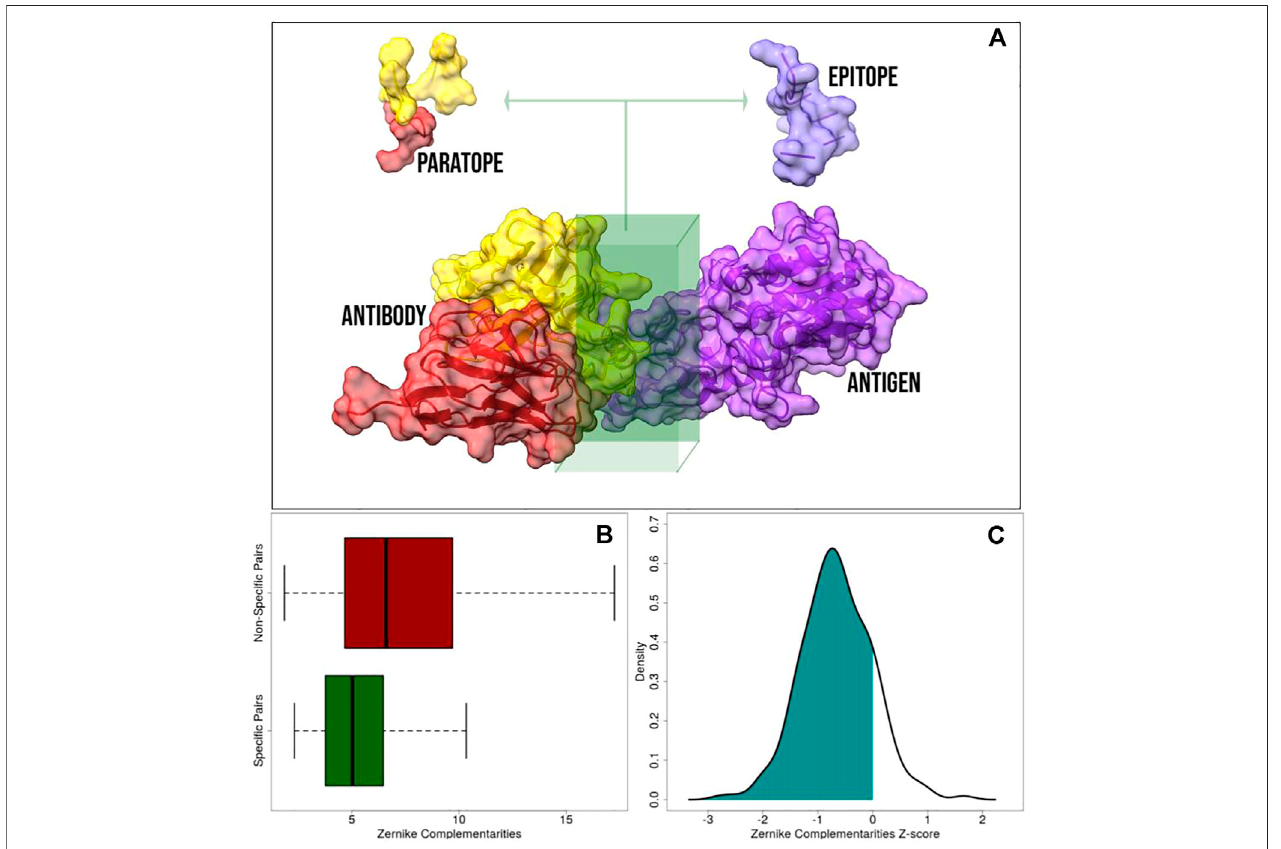
FIGURE1| Applicationofthe2DZernikepolynomialsapproachtoantibody – antigencomplexes. (A) Representationofamolecularantibody – antigencomplex:the antibody heavy chain, antibody light chain, and the antigen are in red, yellow, and purple, respectively. The interacting regions, de fi ned as the portion of the molecular surfaces belonging to residues closer than 4 (cid:1) A to any atoms of the molecular partner, are extracted from the whole surface. (B) Boxplot comparing the speci fi c complementarity , i.e., the complementarity between regions actually found in interaction (green), and the non-speci fi c complementarity , i.e., the complementarity observed between paratopes and epitopes of different complexes (red). It is worth remarking that when the numerical value is low, the complementarity is high. (C) Z-score distribution of the speci fi c complementarity. When the Z-score is lower than 0, the speci fi c interaction is characterized by a complementarity higher than the mean of the non-speci fi c